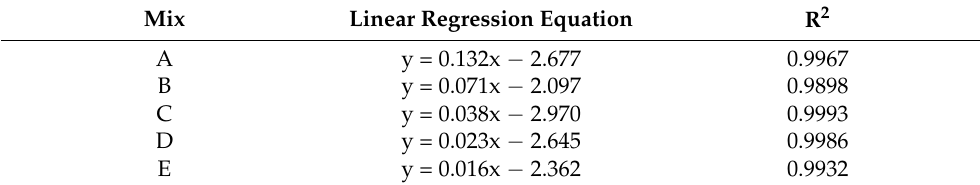
Figure 5. Anode cumulative chloride concentration linear regression results of all mixtures. Table 3. Linear regression parameters for anode chloride concentration of all mixtures.